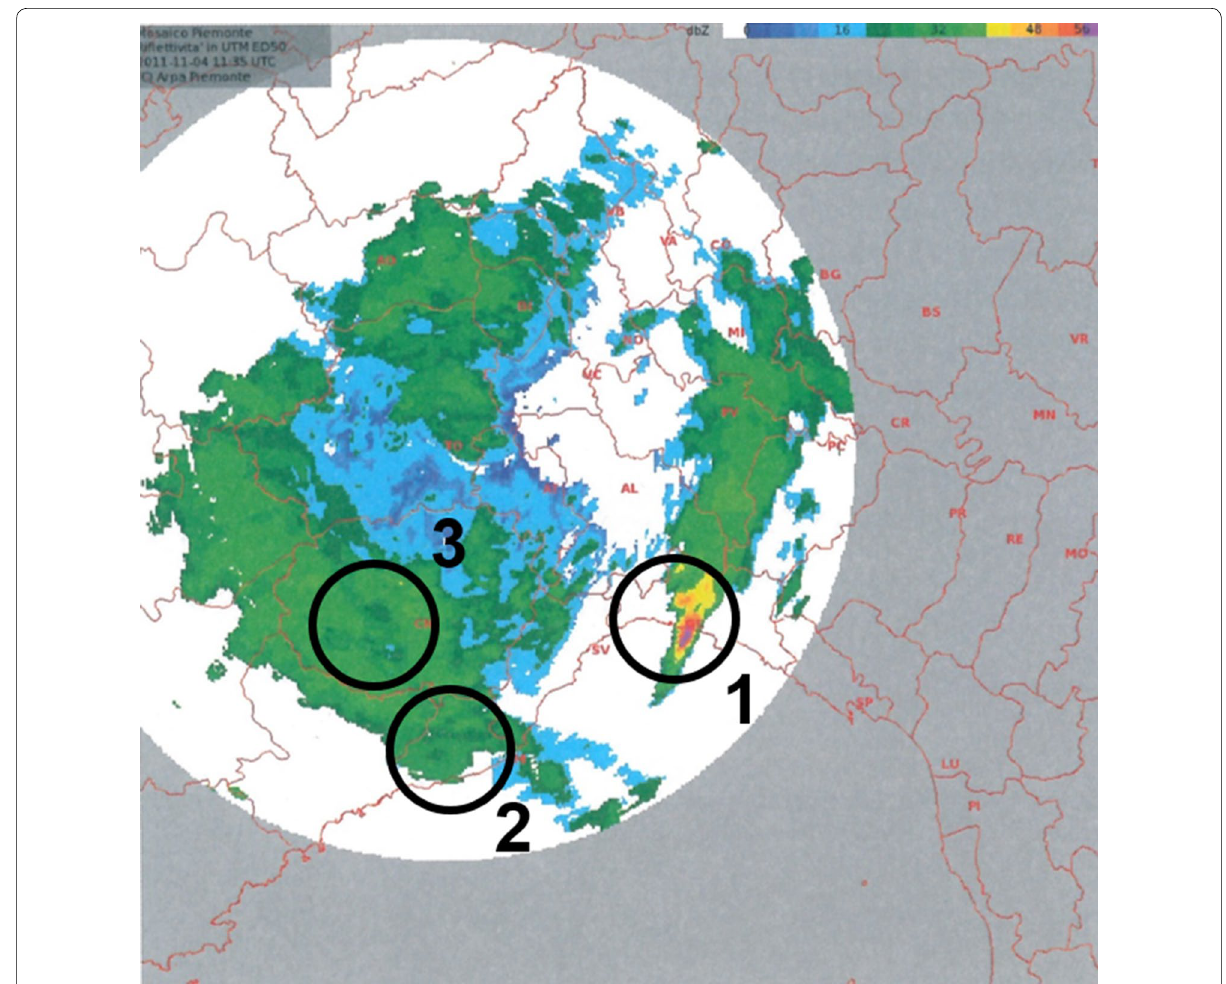
Fig. 11 Reflectivity map observed by the Bric della Croce (Turin, Italy) meteorological radar at 11:35 UTC on November 4, 2011. The localized distri- bution of intense rainfall around Genoa (circle 1) and moderate values elsewhere (e.g., circles 2 and 3) are